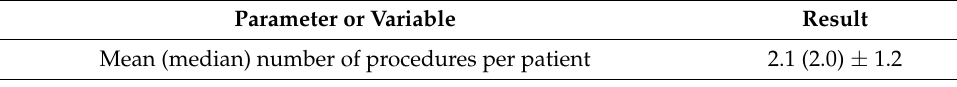
103 (56.3%) 92 (89.3%) 40 (21.8%)